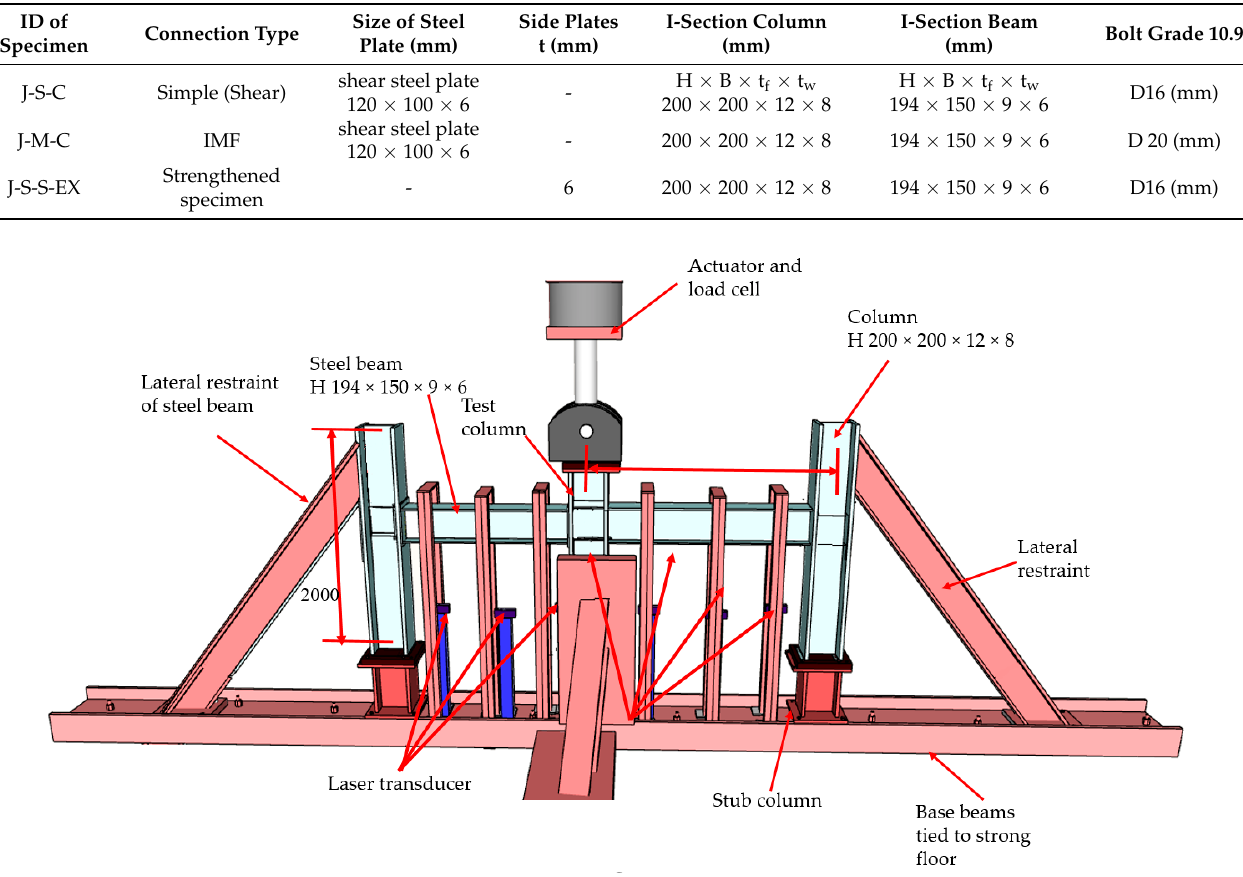
Table 1. Details of the tested steel frame specimens [29].